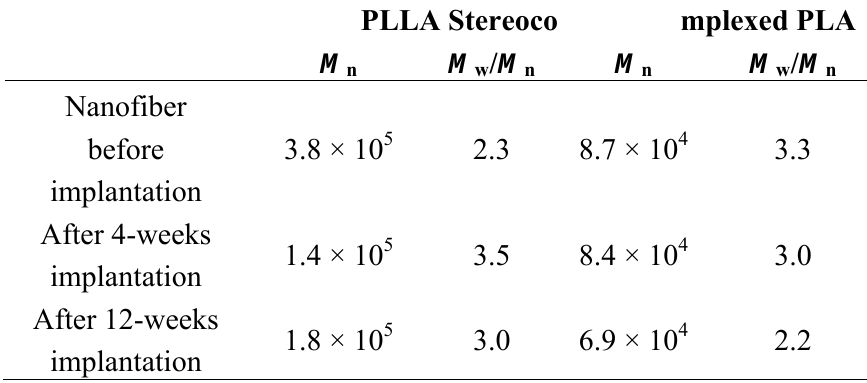
Table 4. Molecular weight of PLA nanofibers before and after 4-week and 12-week degradation in vitro